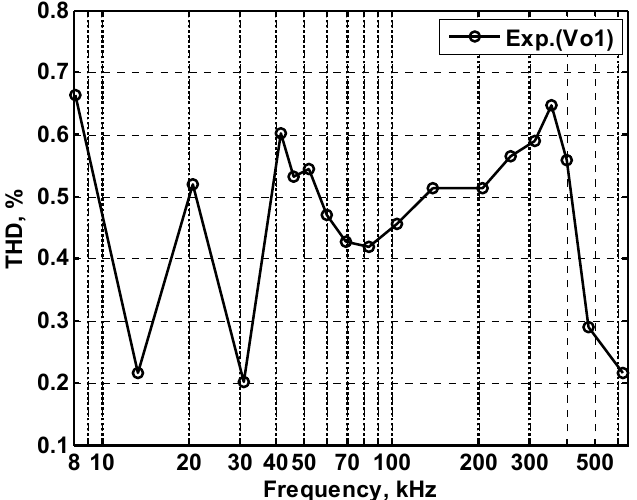
Figure 23. The measured THD of oscillation frequency.